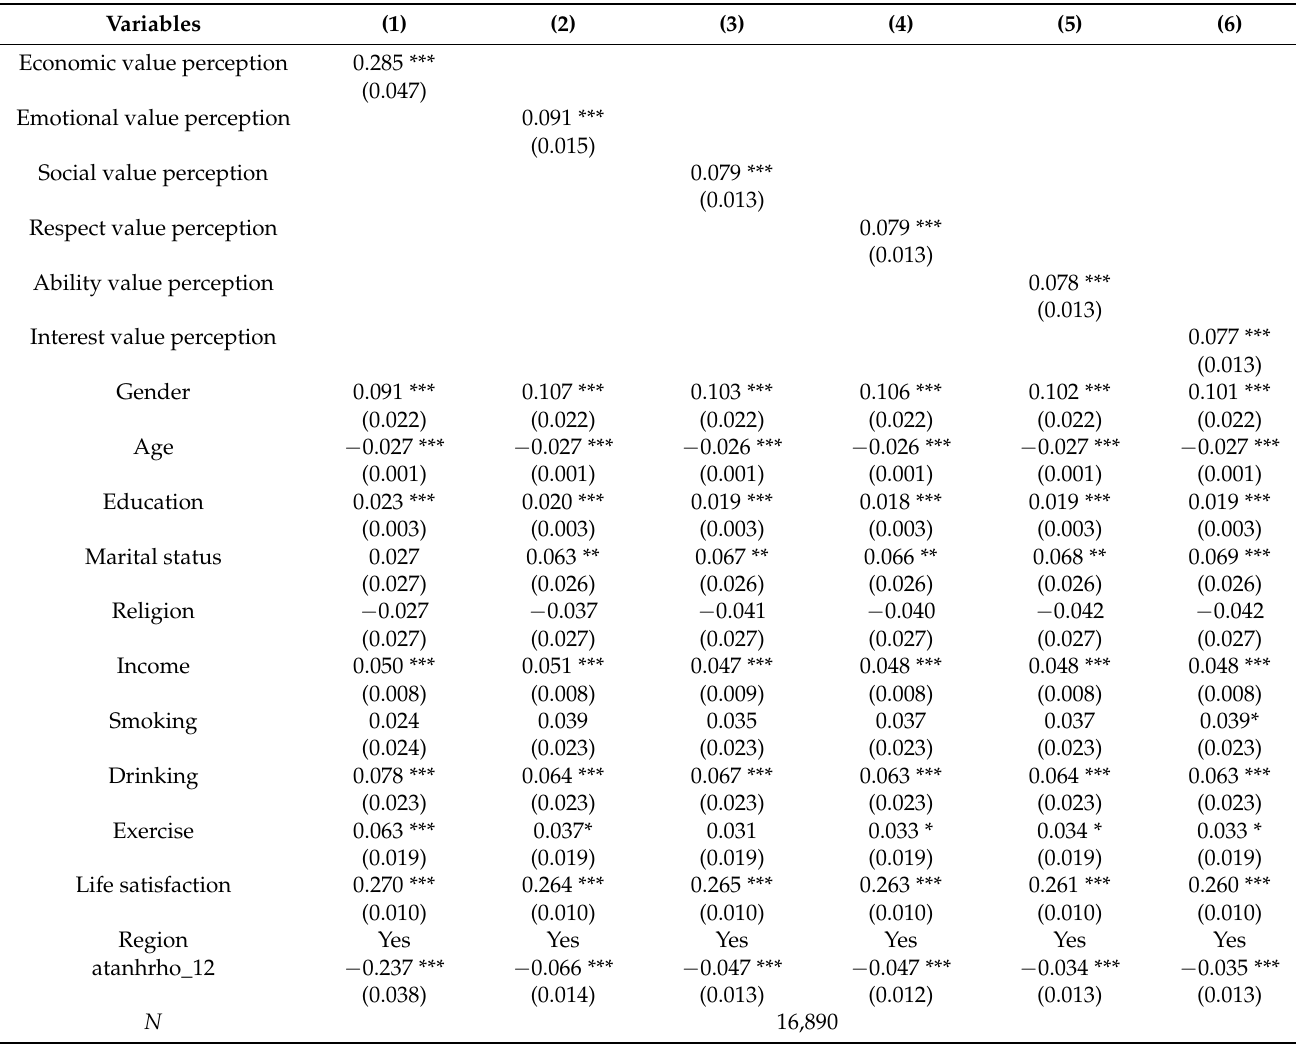
Table 4. Impacts of different work value perception dimensions on workers’ physical health (IV-ordered